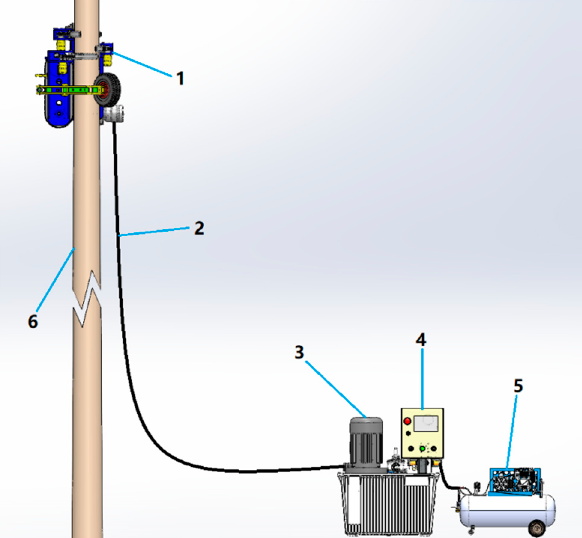
Figure 10. Ground station control principle: 1—Monkeybot; 2—electric hydraulic pneumatic inte- Figure 10. Hydraulic and pneumatic principles: 1—hydraulic station; 2—pressure-reducing valve; grated pipeline; 3—hydraulic station; 4—electric control box; 5—generator; 6—tree 3variable throttle valve; 4—PID control; 5—three-position four-way directional valve; 6—hydraulic lock; 7—hydraulic motor; 8—encoder; 9—air compressor; 10—one-way valve; 11—two-position four-way directional valve; 12—proportional pressure-reducing valve; 13—pressure sensors; 14— clamping cylinder; 15—barrier avoidance cylinder; 16—oscillating cylinder.